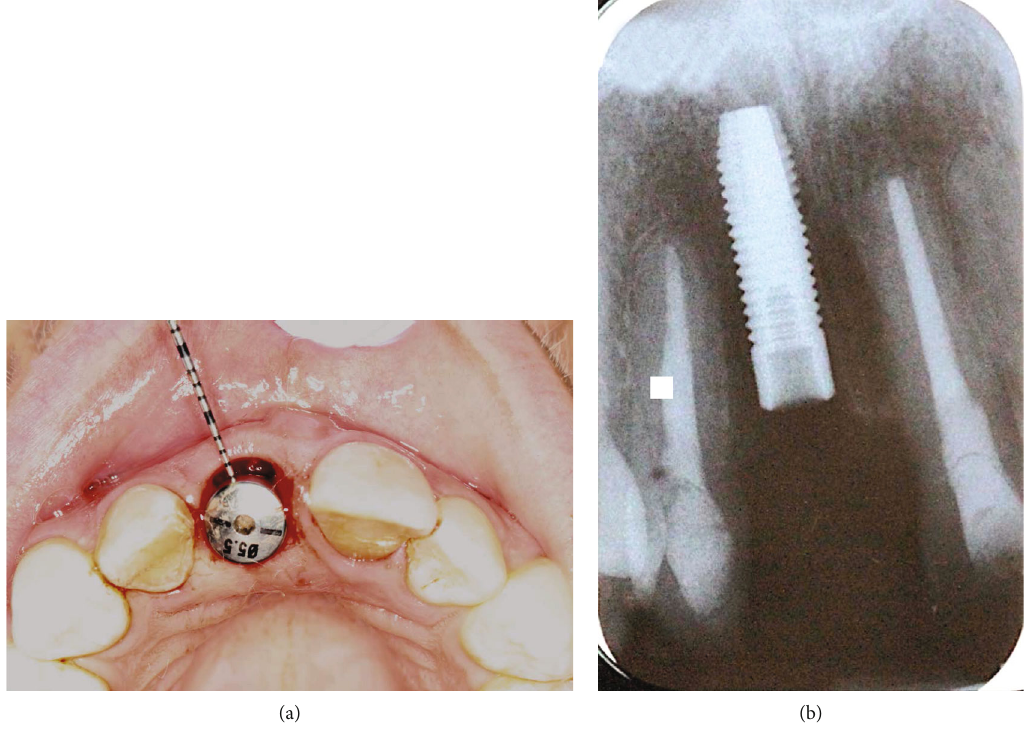
Figure 4: (a) A 5.5mm diameter healing abutment was connected to an OsseoSpeed 4 : 0 × 15 mm implant at the position of tooth 11. (b) A periapical radiograph was taken to validate that the implant shoulder was located at least 3 mm apical to the CEJ of the adjacent